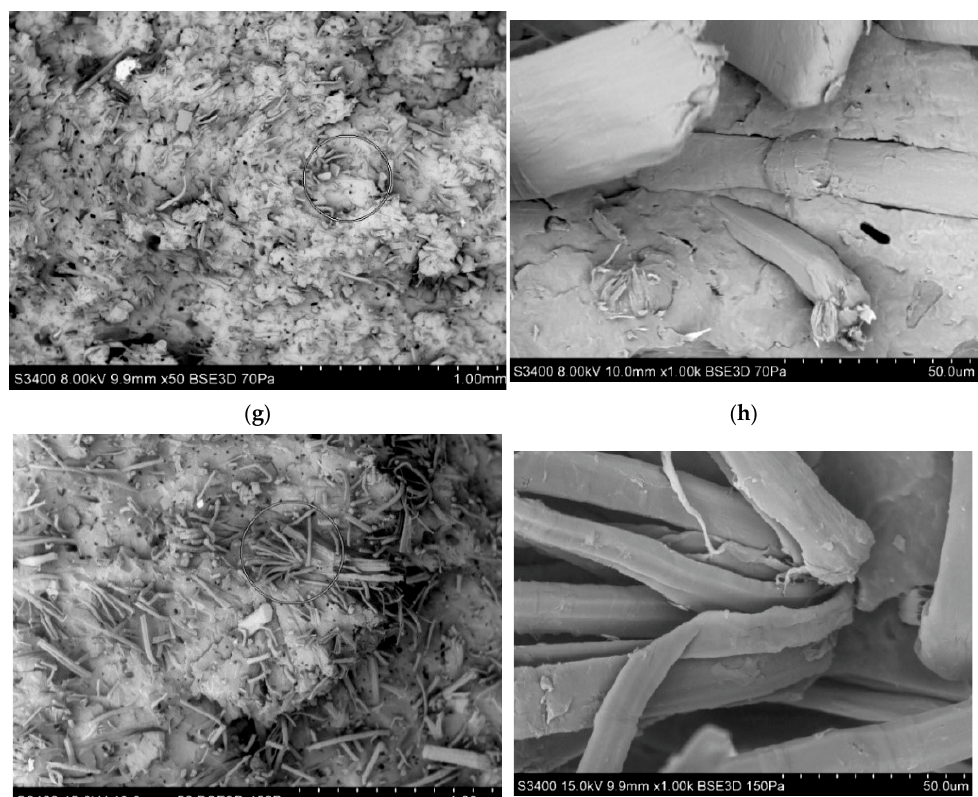
Figure 13. SEM photographs of fractures of PHBV composites: H15TWIN—( a ) magn. 50 × , ( b ) magn. 1000 × , H15SINGLE—( c ) magn. 50 × , ( d ) magn. 1000 × , F15TWIN—( e ) magn. 50 × , ( f ) magn. 1000 × , F15SINGLE—( g ) magn. 50 × , ( h ) magn. 1000 × .